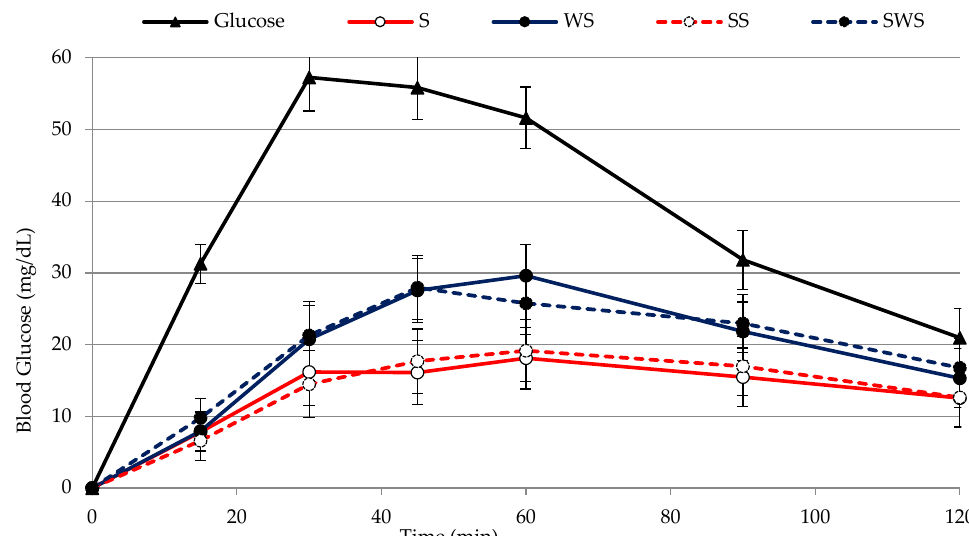
Figure 2. Blood glucose values obtained after in vivo digestion of the four pasta samples. S, pasta with semolina. WS, pasta with wholemeal semolina. SS, pasta with semolina-based sourdough. SWS, pasta with wholemeal semolina-based sourdough. Bars indicate LSD intervals at 95% confidence level.